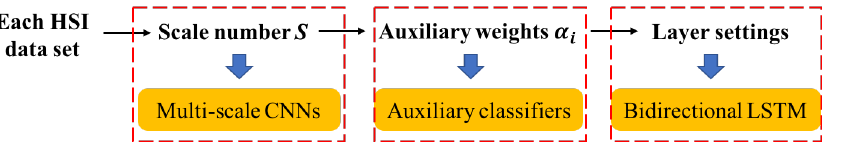
Figure 6. The flow chart of hyperparameter tuning process. For each HSI, we first fix auxiliary weights α i and layer settings in Bi-LSTM, and adjust the input scale number S to find the optimal one. Then we fix scale number S and layer settings in Bi-LSTM to find suitable auxiliary weights α i . The same procedure goes for determining suitable layer settings in Bi-LSTM. Finally, we obtain all the determined hyperparameters.